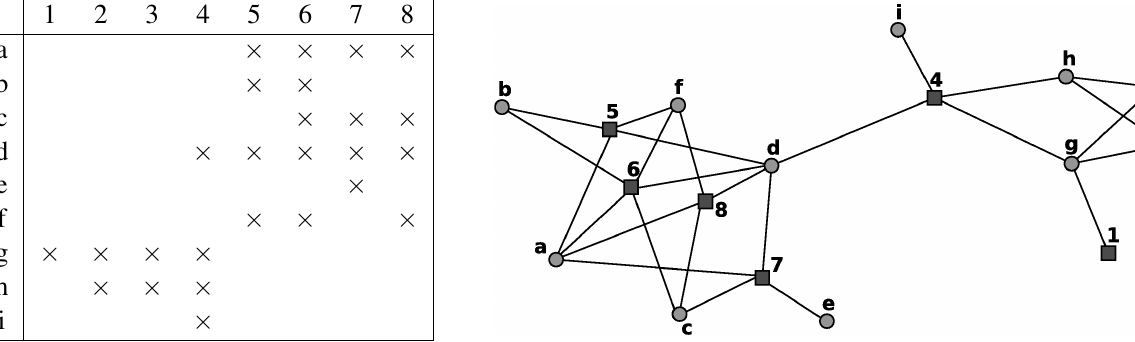
Figure 2: R (cid:48) : Relation R modified and the corresponding